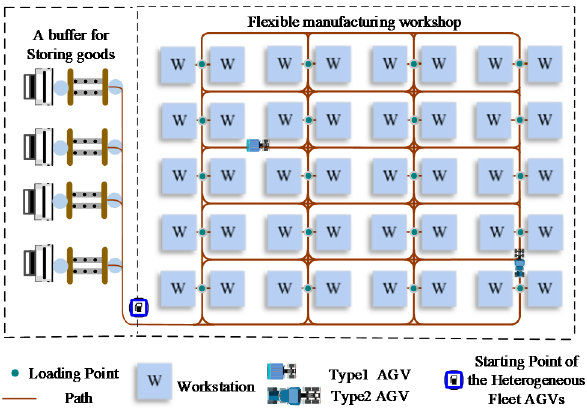
Figure 9. FMS workshop layout.